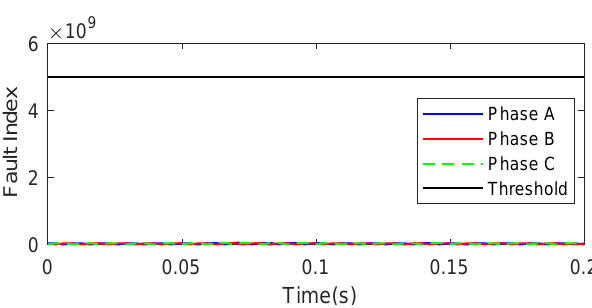
Figure 12. FI at the time of inductive load switching.